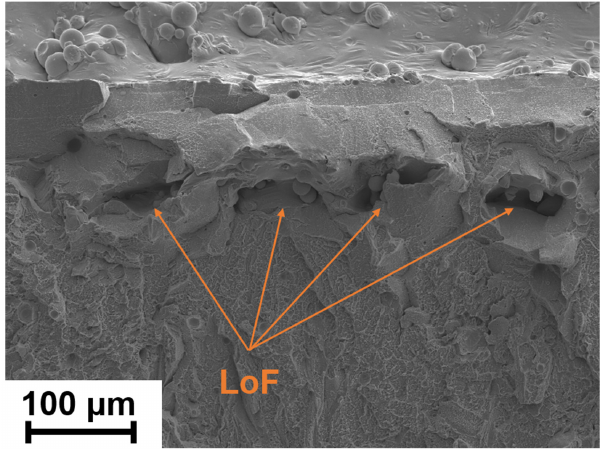
Figure 21. Lack of fusion (LoF) defects close to the external surface of an LPBF AMZ4 specimen after Charpy impact test.